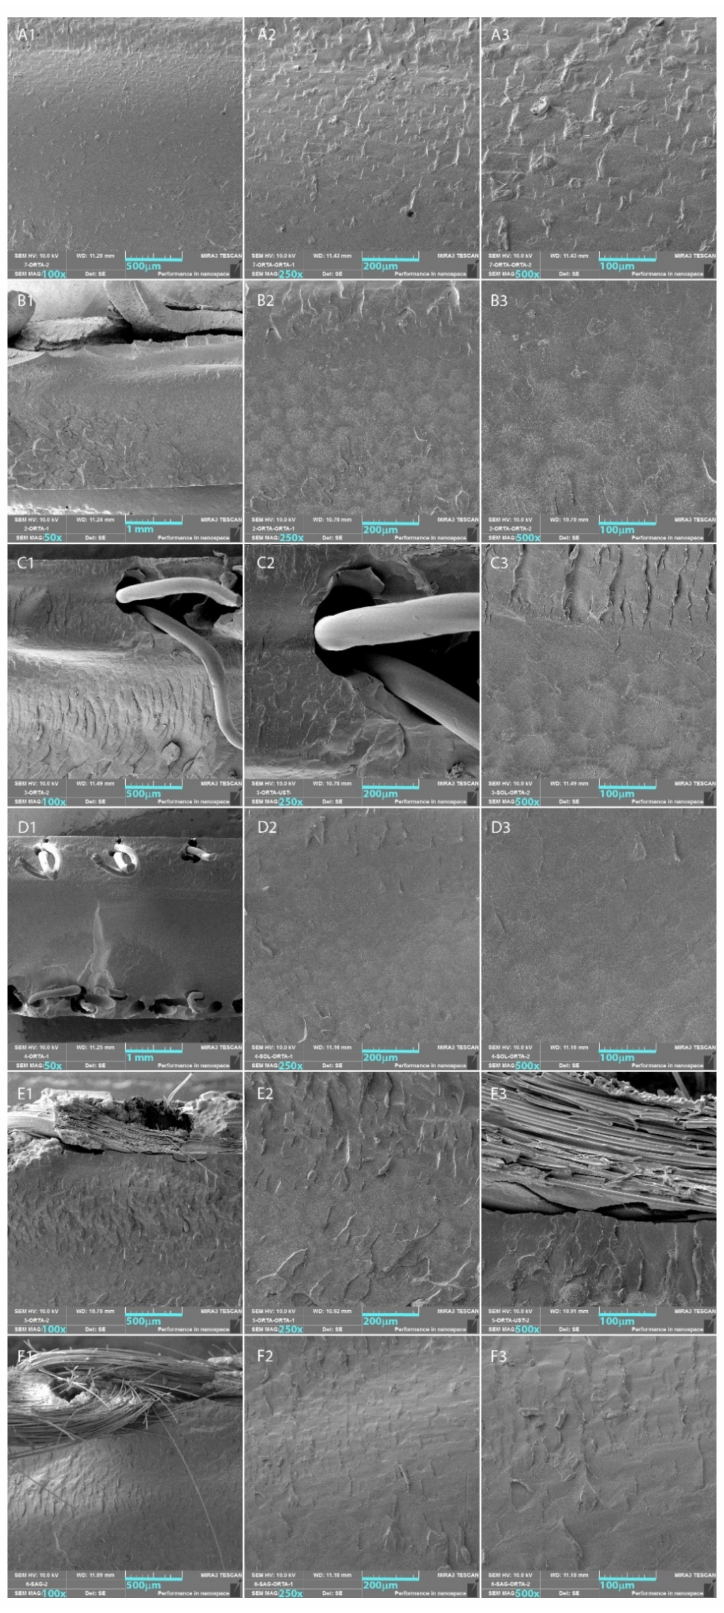
Figure 3. SEM images of the test groups—( A ) Control, ( B ) Al, ( C ) PP1, ( D ) PP2, ( E ) DP0, ( F ) DPA—with different magnifications: (1) 100 × or 50 × , (2) 250 × , (3) 500 ×